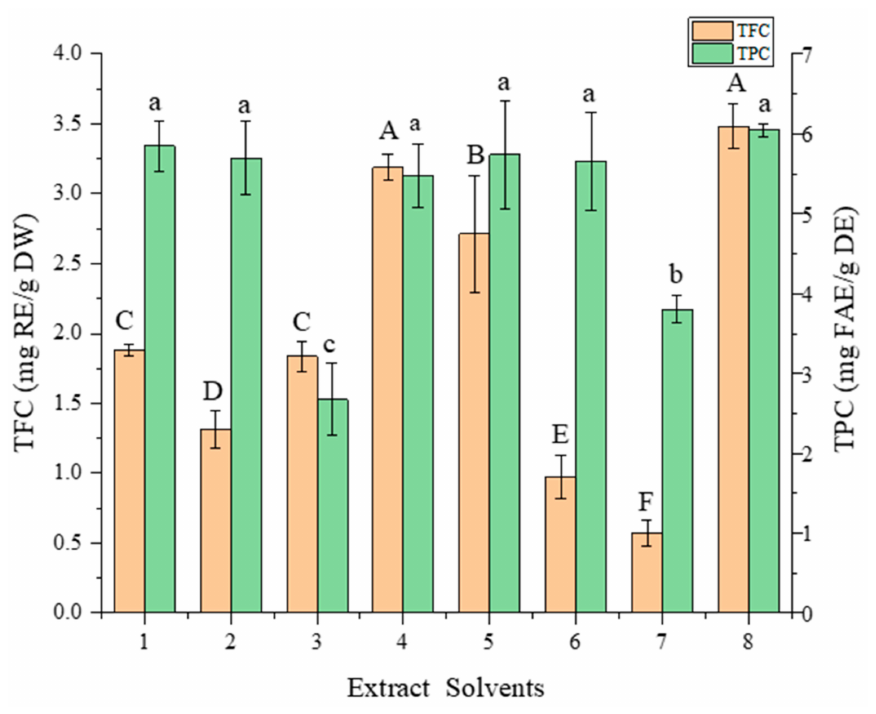
Figure 1. TFC and TPC of foxtail millet husk extracts extracted by different solvents. Different lowercase letters or uppercase letters indicate significant differences ( p <